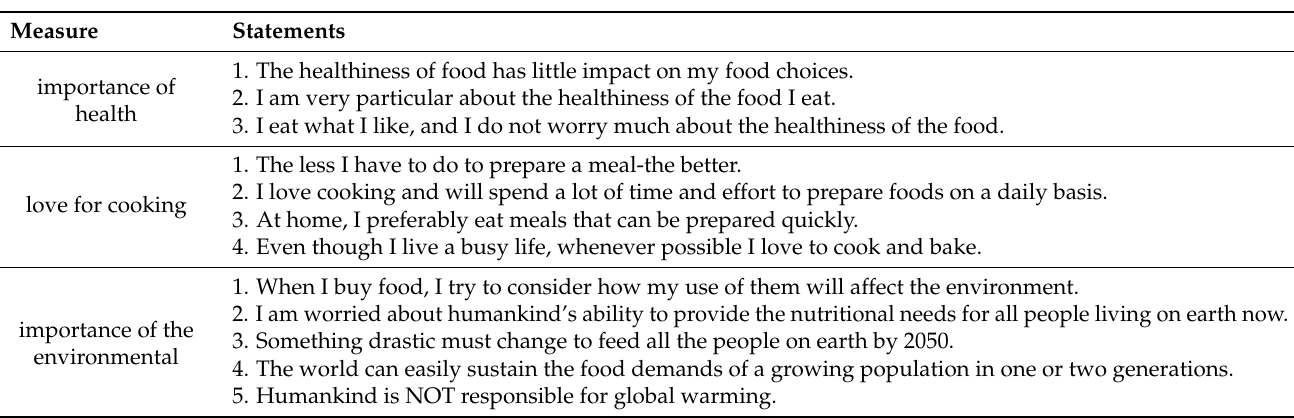
Table 2. Statements belonging to each psychographic